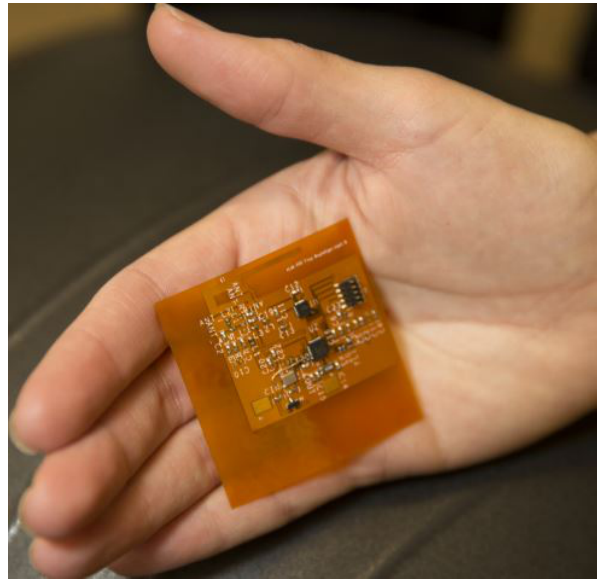
Figure 1. Wearable electronics